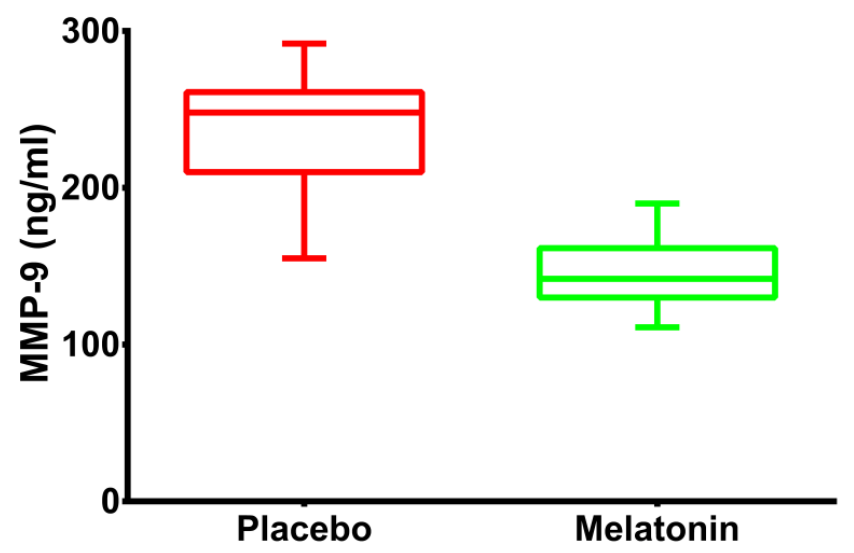
Figure 3. Changes in the levels of MMP-9: Boxplot graphs illustrating the levels of MMP-9 in the 2 treatment arms in patients with acute myocardial infarction undergoing primary percutaneous coronary intervention.